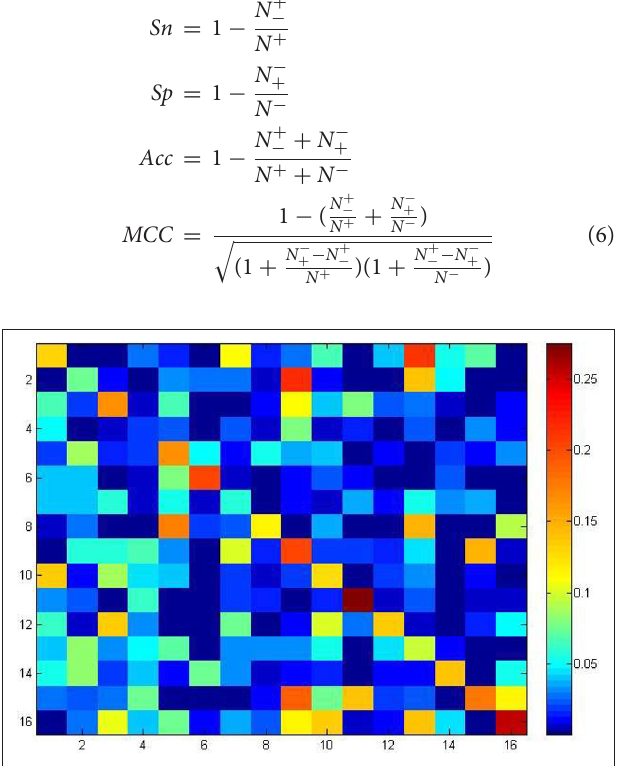
FIGURE 4 | Heap map to illustrate the F_score values of 256 different tetramers to identify ncDNA and cDNA.